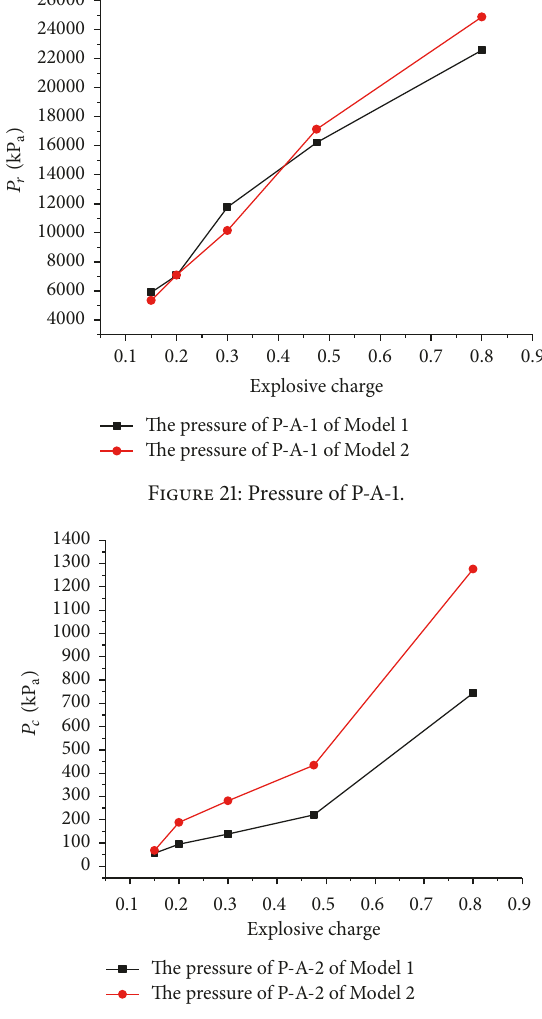
Figure 22: Pressure of